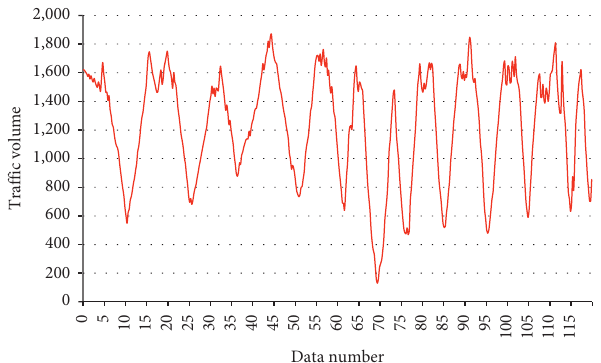
Figure 6: Test results of actual traffic flow.